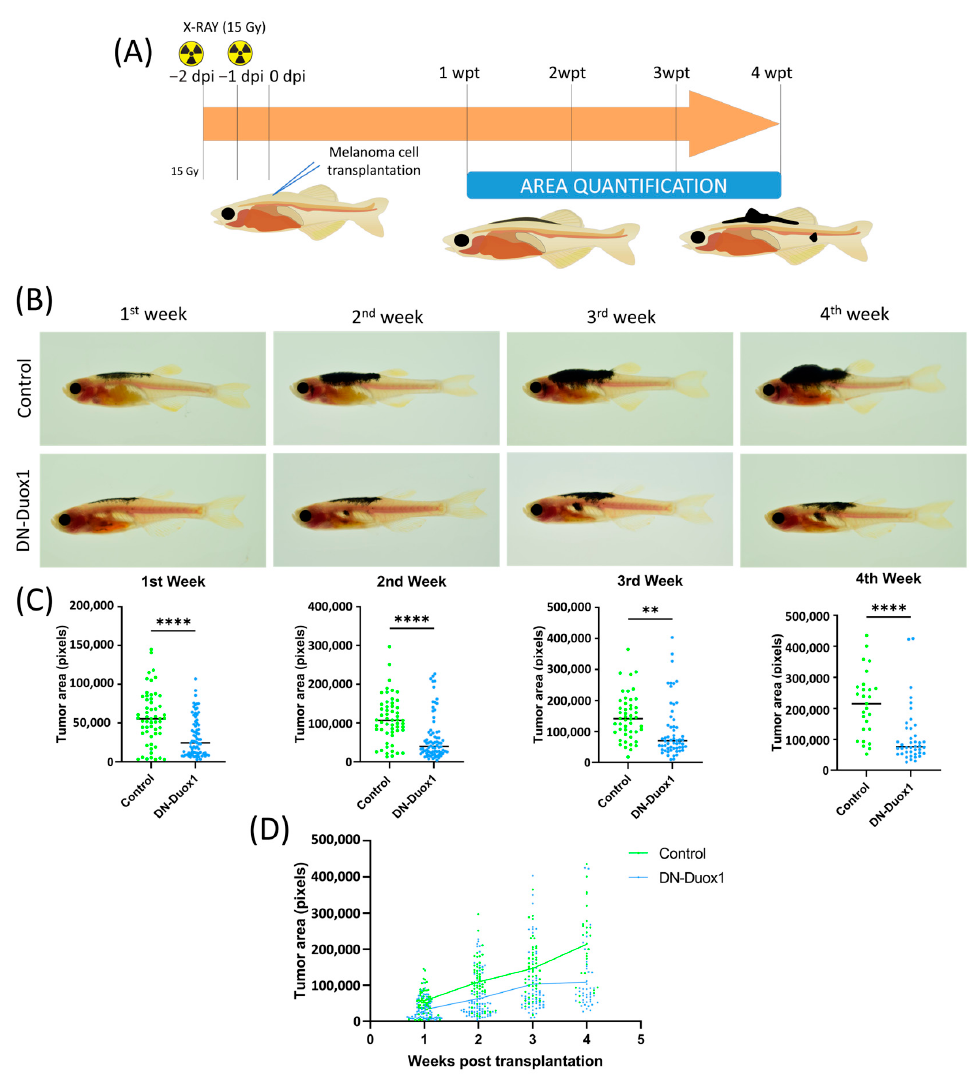
Figure 3. DUOX1 inhibition autonomously reduces aggressiveness and growth of transplanted SKCMs. ( A ) Schematic diagram showing adult allotransplantation procedure. One-year-old Casper zebrafish were irradiated 2 days before transplantation to prevent tumor rejection. Three hundred thousand cells from the nodular tumors of either MinicoopR mitfa:NRAS-QW61R / mitfa:DN-DUOX1 or MinicoopR mitfa:NRAS-Q61R / mitfa:EGFP (control) fish were subcutaneously injected in pre-irradiated recipients, and images were taken weekly during the following 4 weeks after transplantation and analyzed as indicated in the Methods and Materials section. Arrow, timeline; dpi, days post-injection; wpt, weeks post-transplant. ( B ) Representative images of transplanted melanoma growth rate of MinicoopR mitfa:NRAS-QW61R / mitfa:DN-DUOX1 and MinicoopR mitfa:NRAS-Q61R / mitfa:EGFP in pre-irradiated adult Casper zebrafish. ( C ) Average tumor size for each week post-transplant. Each dot represents a recipient-transplanted fish, and the mean is also shown. ** p < 0.01, **** p < 0.0001 according to unpaired Student t test. ( D ) Growth rate of transplanted MinicoopR mitfa:NRAS-QW61R / mitfa:DN-DUOX1 and MinicoopR mitfa:NRAS-Q61R / mitfa:EGFP SKCMs. DN-DUOX1: n = 5 tumors and 111 recipient fish; EGFP: n = 3 tumors and 72 recipient